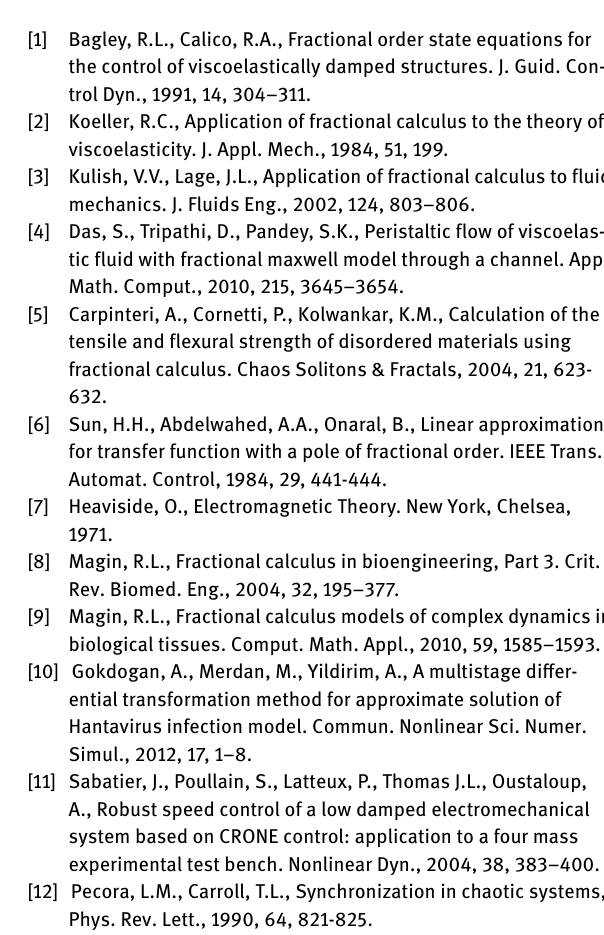
Fig. 4: The evaluation of error functions e 1 ( t ), e 2 ( t ) and e 3 ( t ) at q = 1 : (a) for three systems; (b) for four systems.